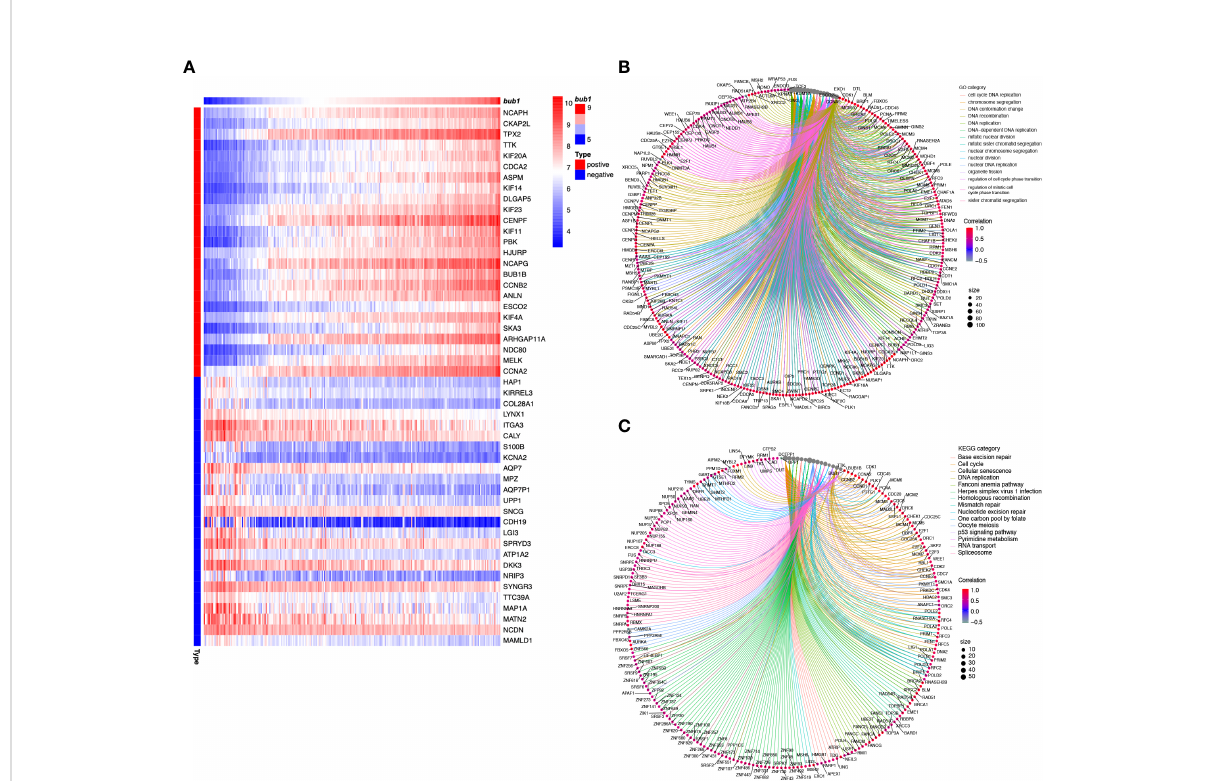
FIGURE 4 Molecular function analysis of bub1 in neuroblastoma. (A) Enrichment heat map of bub1 -related genes. Genes strongly co-expressed with bub1 are exhibited in order of Spearman ’ s correlation coef fi cient. (B) Gene ontology (Go) enrichment analysis of bub1 . (C) Kyoto Encyclopedia of Genes and Genomes (KEGG) analysis of bub1